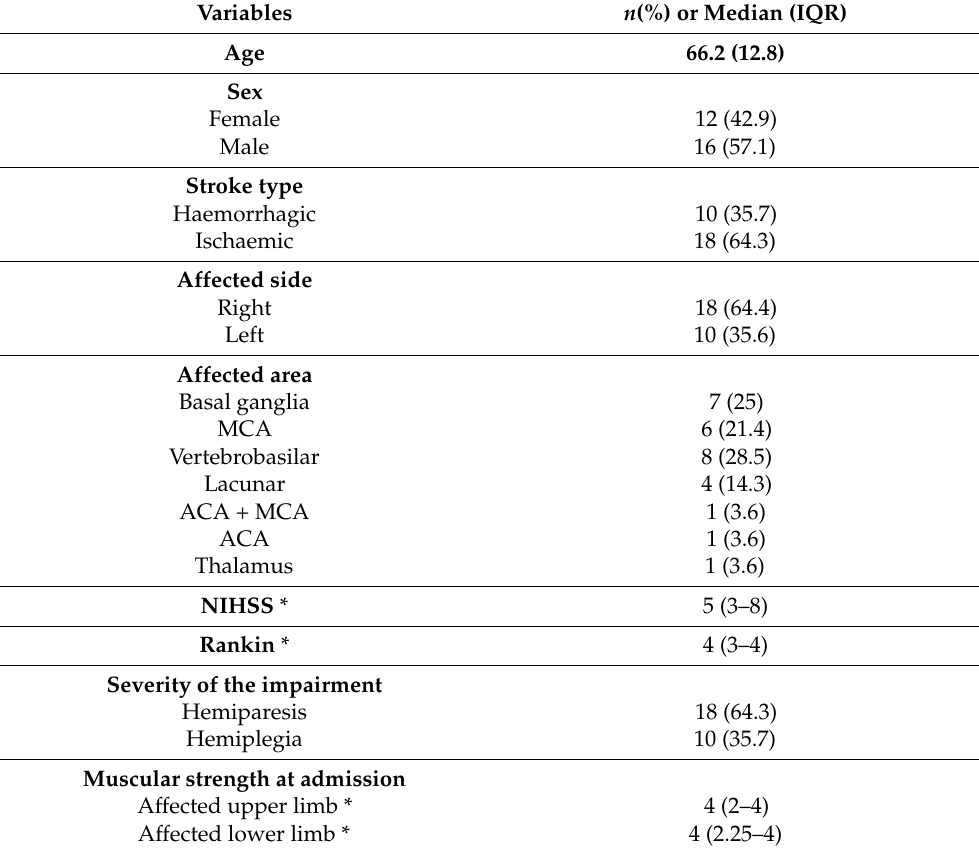
Table 1. Baseline characteristics of the study